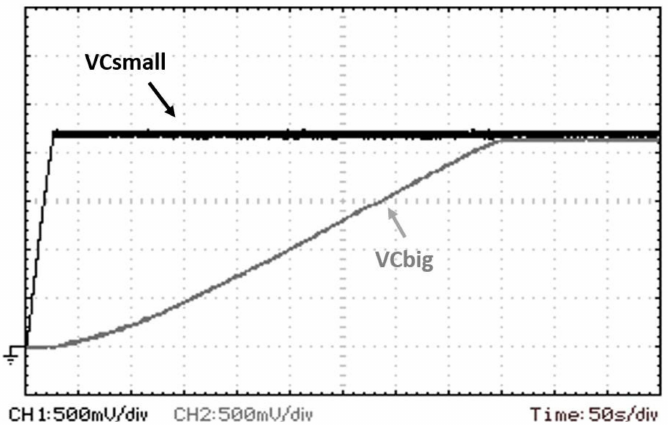
Figure 15. SCsmall (CH1) and SCbig (CH2) charging phase from the piezoelectric